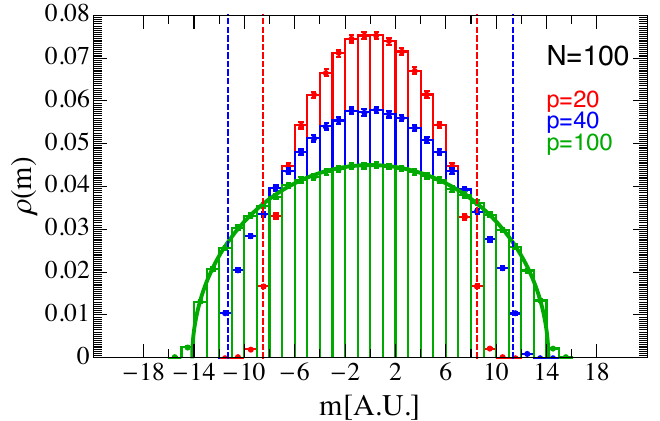
Figure 4. Spectral density of 100 (cid:2) 100 symmetric band matrices with elements drawn randomly from Gaussian distributions. We have used (cid:22) d = (cid:22) o = 0 and (cid:27) d = correspond to di(cid:11)erent numbers of interacting neighbors p . The vertical lines show the estimate of the distribution width given in eq. (4.25) from dimensional